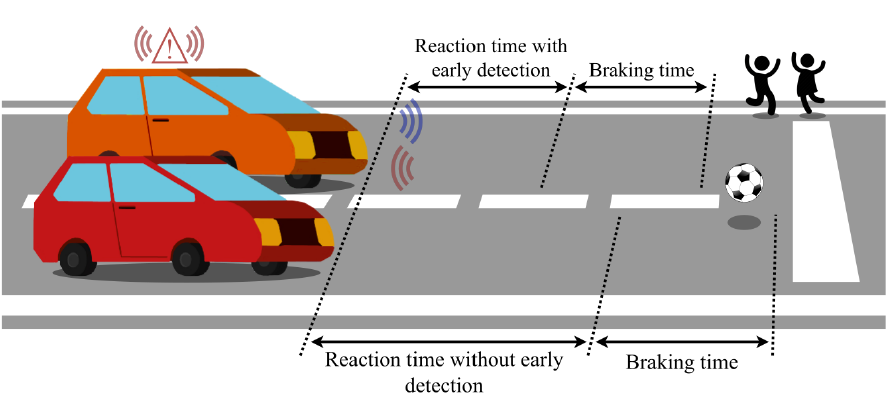
Figure 1. Illustration of a time-critical situation with and without proposed early detection chain. The braking times are identical. Reaction time can be reduced by using low-latency hardware processing (upper car). Reaction and braking times are not to scale; braking time is typically much